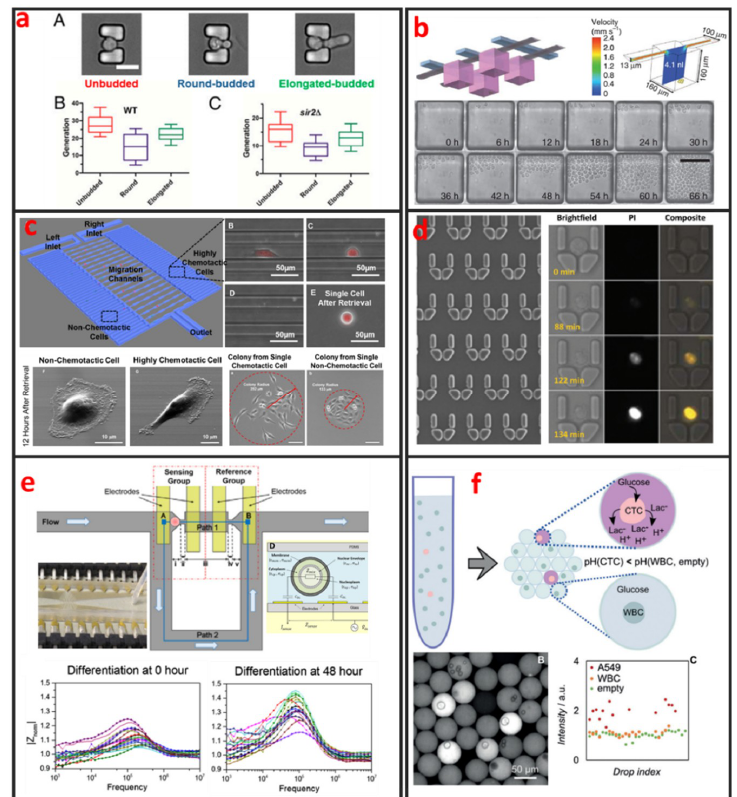
Figure 8. Cellular analysis of single-cells by using microfluidics. ( a ) Characterization of terminal